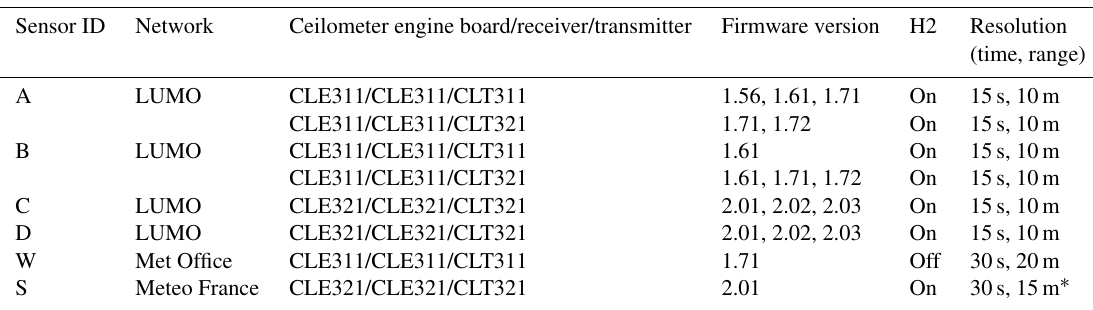
Table 2. Vaisala CL31 ceilometer specifications of sensor hardware, firmware, H2 noise setting, and resolution selected by the user. The term “H2” is discussed in Sect.